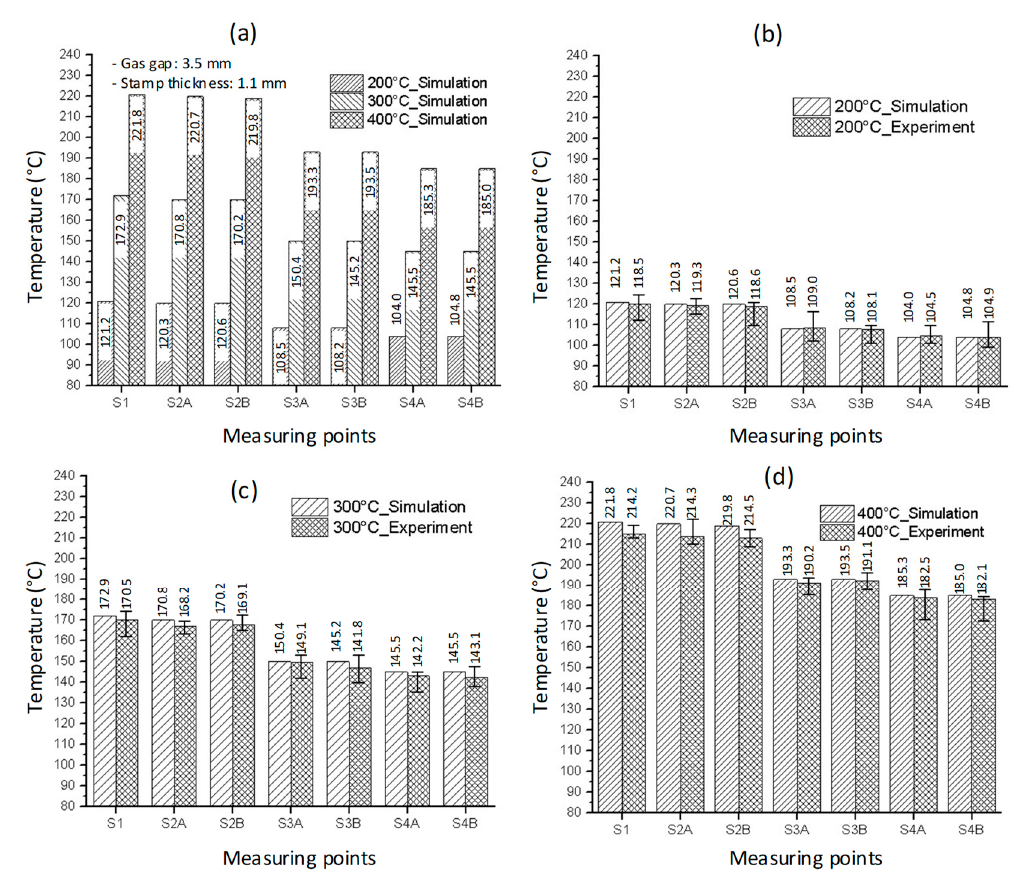
Figure 15. The comparison of temperatures ( a ) at measuring points with different inlet temperatures and comparison of simulation and experiment with the inlet temperature of ( b ) 200 ° C, ( c ) 300 ° C, and ( d ) 400 ° C with a heating time of 20 s and stamp thickness of 1.1 mm.